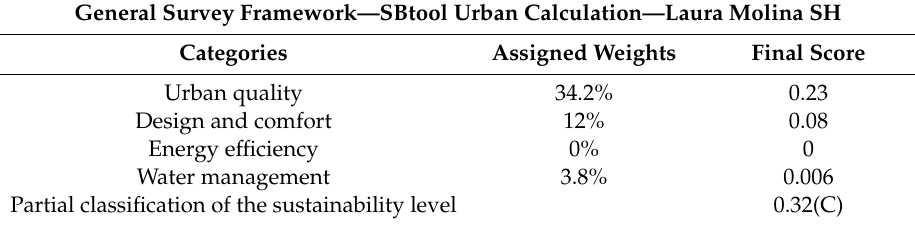
Table 9. Evaluation profile of Laura Molina